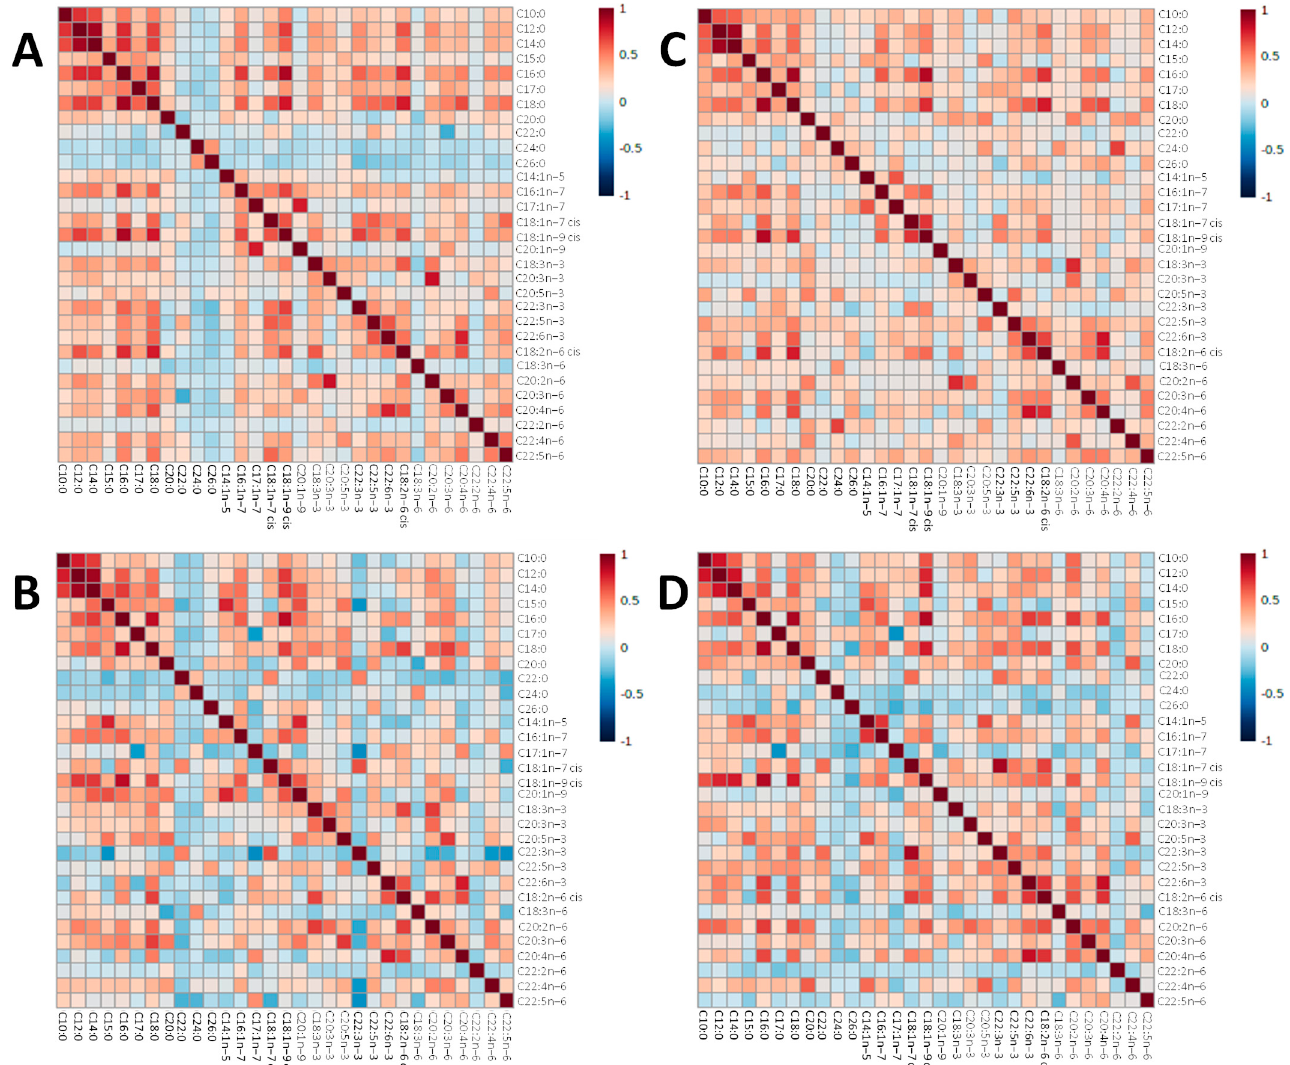
Figure 5. Heatmaps representing pairwise correlations between all serum non-esterified fatty acids concetrations (ug/mL) in undernourished and healthy control children at 3 – 6 months and 9 months of age. In the heatmap, red represents higher correlation, and blue shows lower correlation between a pair of markers. ( A ) Undernourished group at 3 – 6 months. ( B ) Healthy control group at 3 – 6 months. ( C ) Undernourished group at 9 months. ( D ) Healthy control group at 9 months.